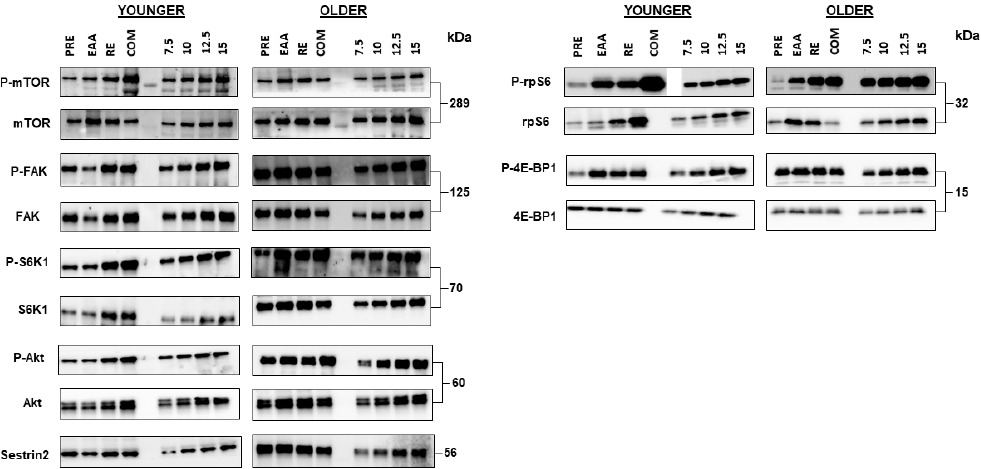
Figure 2. Phosphorylation of Akt at Ser473 2 h following EAA, RE, and COM in healthy younger ( n = 7) and older ( n = 7) individuals. The symbol ( # ) denotes statistical significance between age groups. Data are means ± SEM.